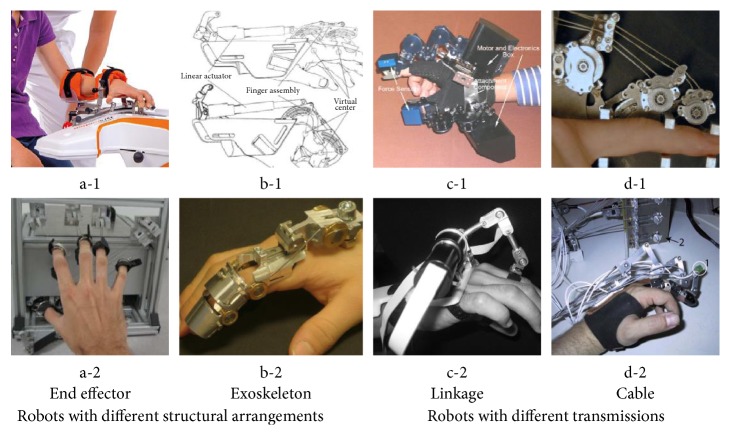
Examples of different kinds of robots [10, 19, 20, 54, 55, 57, 58, 74, 76–78].